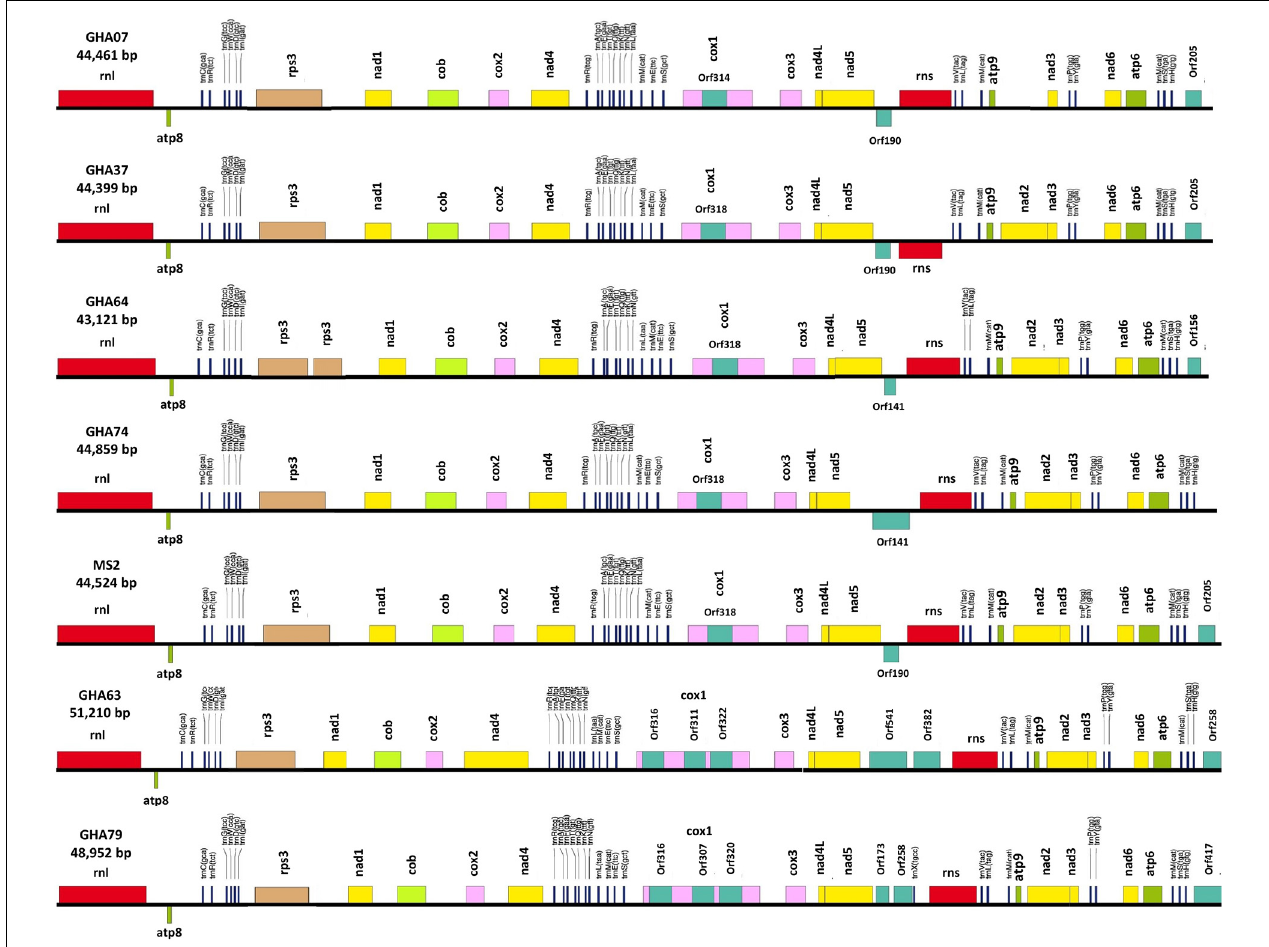
FIGURE 3 | Conservation of gene order and Intraspecies variation in the mitogenome structure of seven isolates of the cacao thread blight associated pathogen Marasmius tenuissimus. Mitochondrial gene annotation was performed with MFannot using the NCBI translation code 4, and the physical map of the mitogenomes were created with OrganellarGenome-DRAW (OGDRAW) v